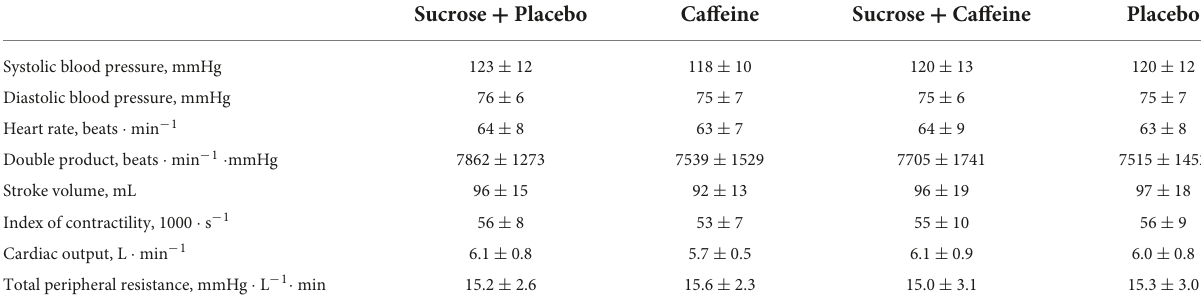
TABLE 1 Continuously and beat-to-beat recorded baseline hemodynamic data averaged over the last 15 min of a 30 min baseline in seven healthy, non-obese men included in the study after recruitment who ingested four different drinks in a randomized crossover fashion. Sucrose + Placebo Caffeine Sucrose + Caffeine Placebo